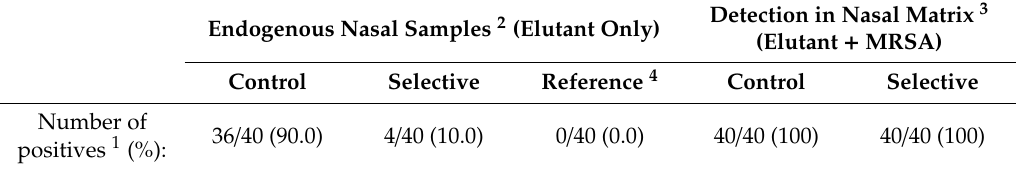
Table 5. Screen performance with non-colonized nasal